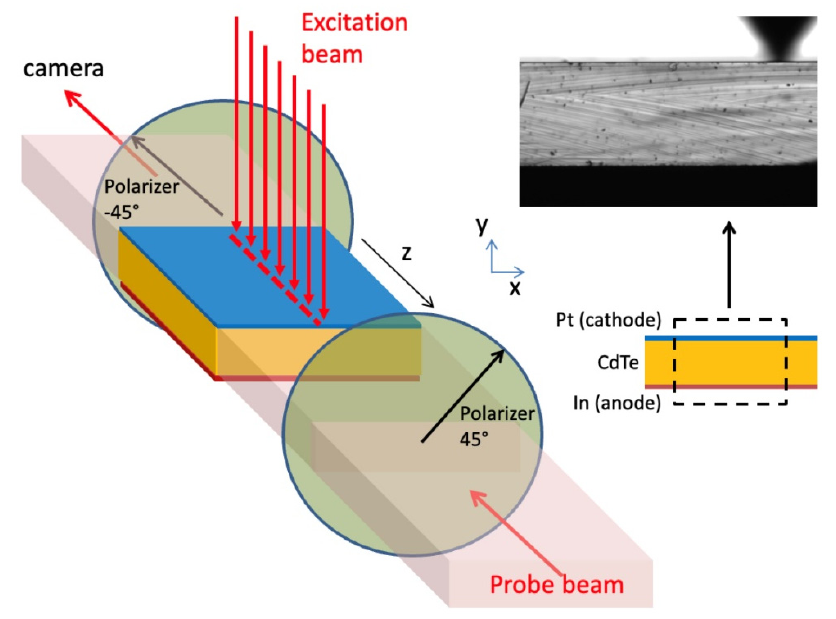
Figure 1. A sketch of the experiment: the line-focused optical excitation beam is incident on the cathode side of the CdTe diode-like detector (left), whereas the 980 nm probe beam laterally crosses the detector in a cross-polarizer configuration. On the right, a picture of the detector section and above it an image of the transmitted intensity with both polarizers aligned and no voltage applied ( P para ). The other optical beam used in our setup is the excitation beam, which is line-focused on the cathode side along the z -direction (see Figure 1) upon using a cylindrical lens,